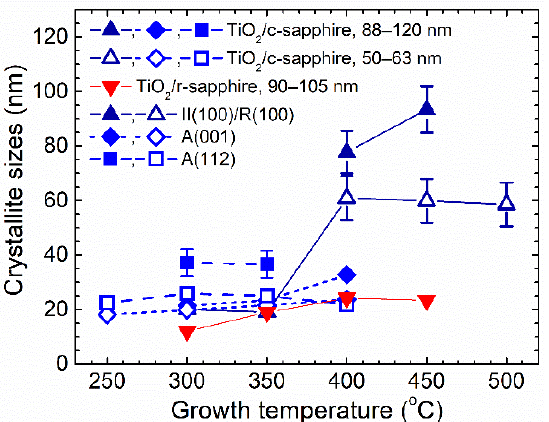
Figure 7. Crystallite sizes as a function of growth temperature. In the films deposited on c-sapphire, the crystallite sizes were determined for (1 0 0) oriented TiO 2 -II/rutile (II(1 0 0)/R(1 0 0)), (0 0 1) oriented anatase (A(0 0 1), and (1 1 2) oriented anatase (A(1 1 2)). In the films grown on r-sapphire, crystallite sizes were determined for (1 0 1) oriented rutile. Thickness ranges of the films characterized are shown in the figure.